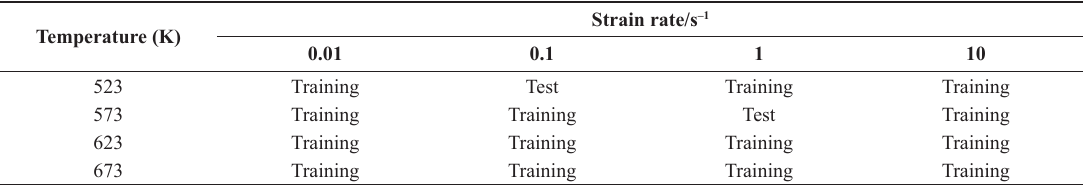
Table 1. The clarification of training dataset and test